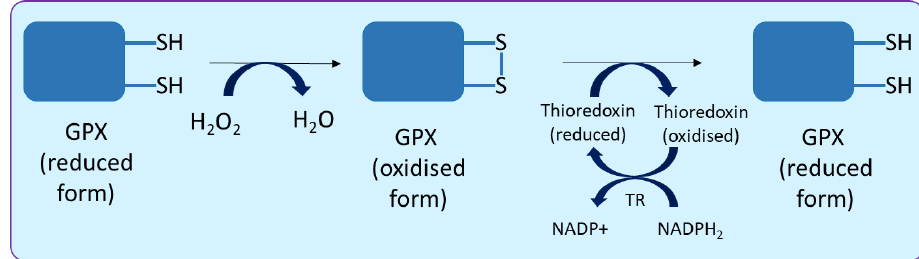
Figure 4. Reaction mechanism of glutathione peroxidase (GPX).